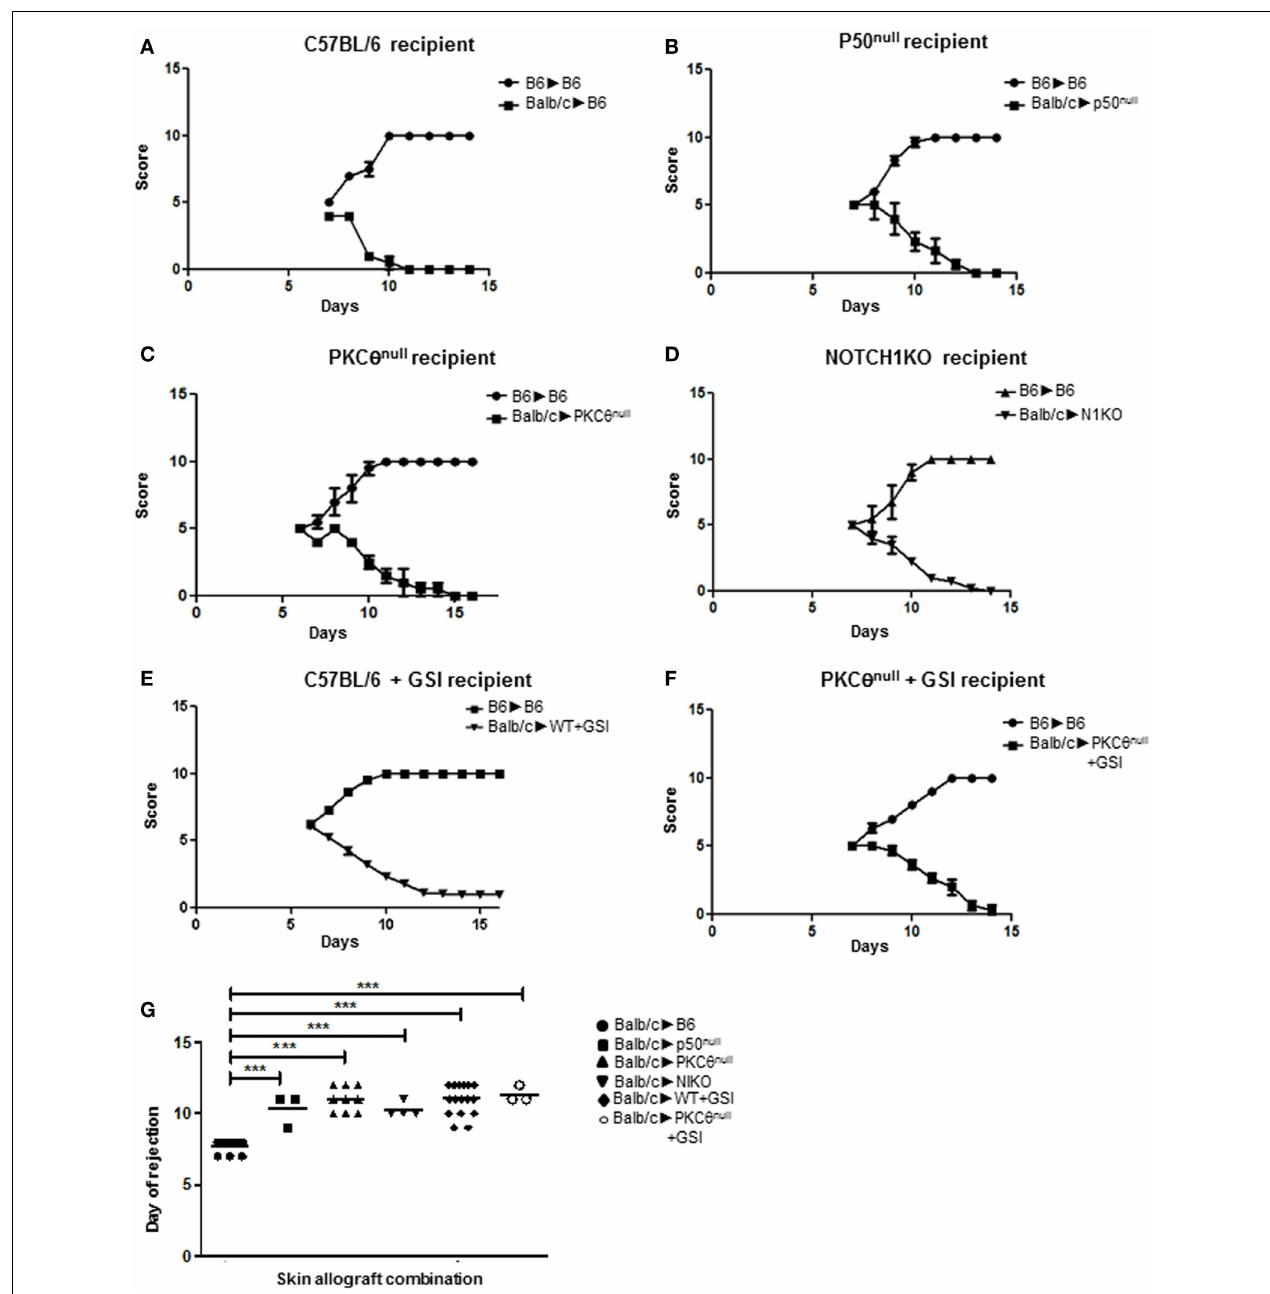
(BALB/c → PKC θ null ); (D) NOTCH1 conditional knock-out (N1KO) mice (BALB/c → N1KO); (E) wild-type C57BL/6 mice whose NOTCH signaling was abrogated by administering γ -secretase inhibitor (GSI LY411,575; BALB/c → WT + GSI); and (F) PKC θ null mice whose NOTCH signaling was abrogated by administering γ -secretase inhibitor (GSI LY411,575) in chow (BALB/c → PKC θ null + GSI). (G) Day to complete rejection was compared between different groups of recipient mice. For each animal grafted with BALB/c skin, an internal control of C57BL/6 skin was also grafted (BL6 → BL6) to monitor integrity of the grafting technique. Data represent the mean + SEM ( n = 3–16 mice/group). *** P < 0.001; one-way ANOVA withTukey’s post-test